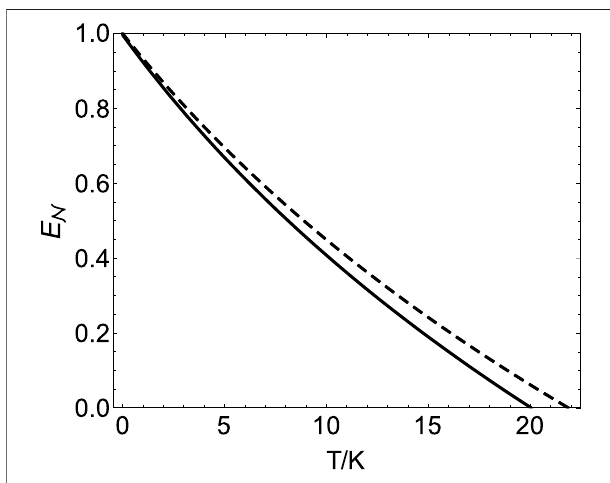
FIGURE7| Logarithmicnegativity E N asafunctionoftemperature ofthe systemfor different masses ofoscillators.The solidlinerefersto m (cid:1) 5 ng, the mass corresponding to the dash line is m (cid:1) 50 ng, and the normalization (cid:1) 1. detuning Δ ω m